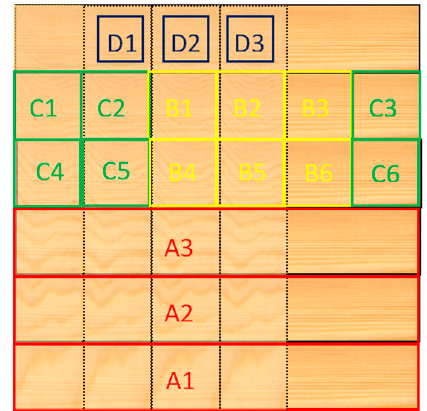
Figure 2. Sampling diagram of CLT.